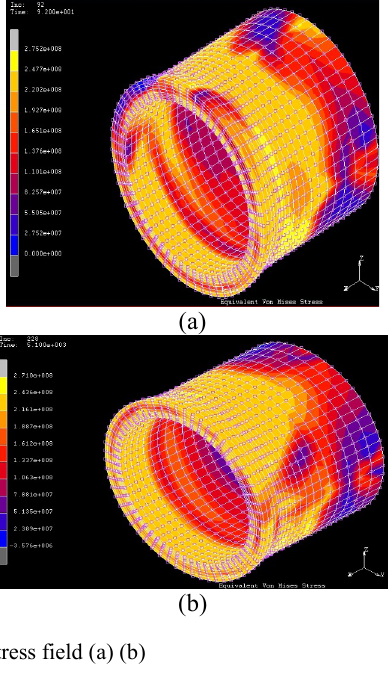
Figure 9 Stress field (a)